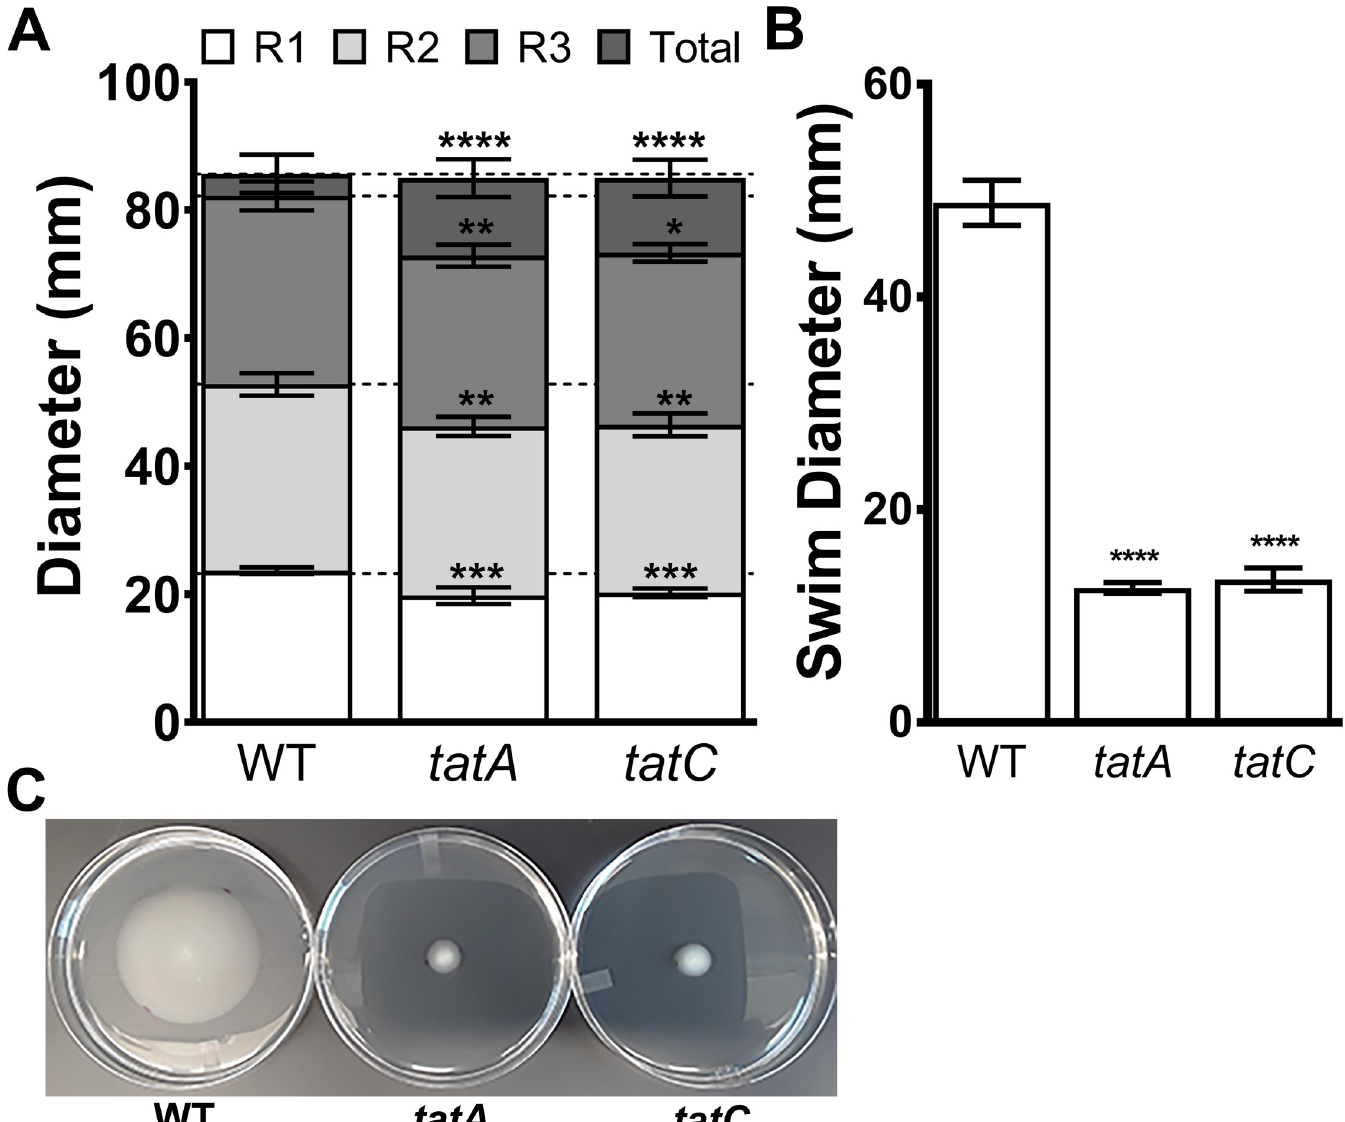
Fig 7. Disruption of the Tat system impacts swimming but not swarming motility. (A) Swarm diameters of the first (R1), second (R2), and third (R3) swarm rings and total swarm diameter of wild-type P. mirabilis HI4320 and isogenic mutants tatA and tatC inoculated on LB agar with 5g/L NaCl after 18 hours of incubation at 37˚C. Dashed lines indicate average swarm ring diameter for WT. Error bars represent the mean ± standard deviation from 3 independent experiments with 3 replicates each. �� P < 0.01, ��� P < 0.001, and ���� P < 0.0001 as determined by two-way ANOVA. (B) Swimming motility on MOT agar stab inoculated with wild-type P. mirabilis HI4320 and isogenic mutants tatA and tatC , incubated at 30˚C for 18 hours. Error bars represent the mean ± standard deviation from 3 independent experiments with 4 replicates each. ���� P < 0.001 compared to WT as determined by Student’s t-test. (C) Representative image of wild-type P. mirabilis HI4320 and isogenic mutants tatA and tatC swimming on MOT